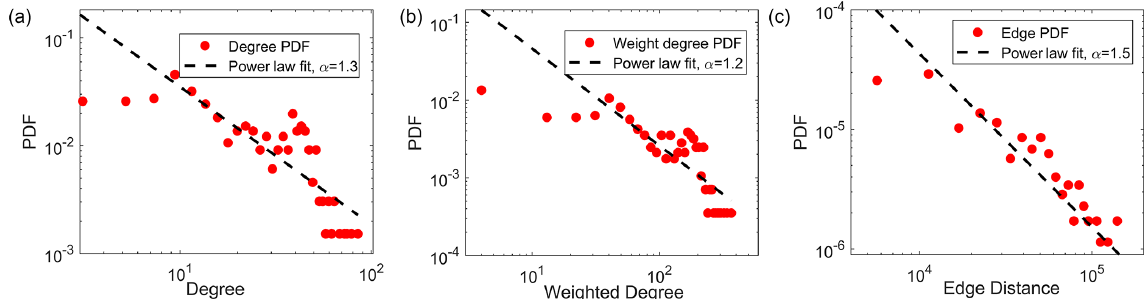
Figure 4. (a) PDF for degree values (red dots) and the power law fit curve (black line). (b) PDF for weighted degrees (red dots) and the power law fit curve (black line). (c) PDF for edge lengths (km) (red dots) and the power law fit curve (black